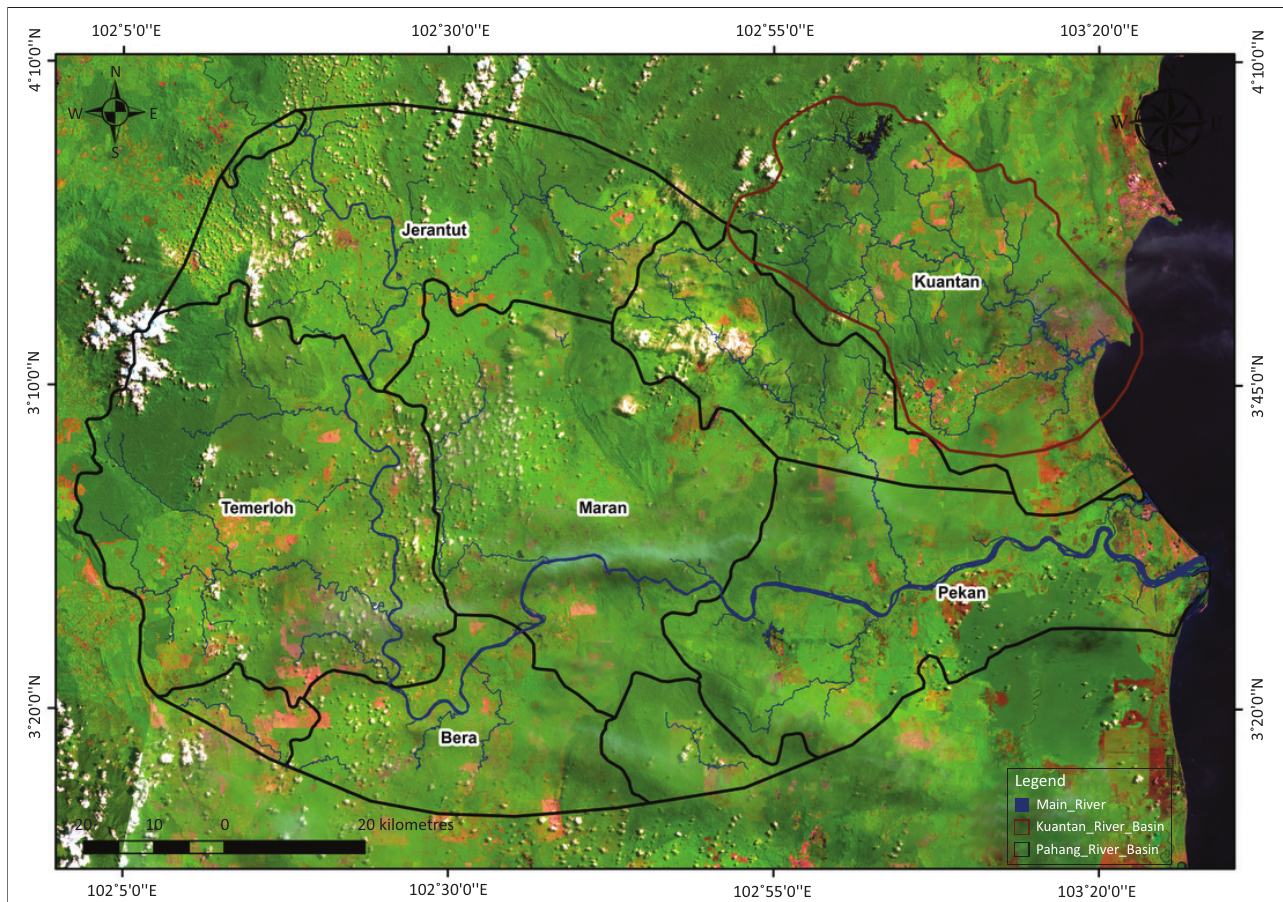
FIGURE 1: Pahang and Kuantan river basins of Peninsular Malaysia, showing the study